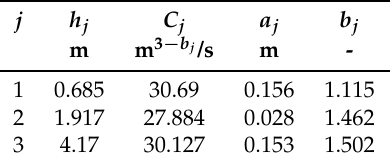
Table 1. The latest [14] coefficients C j , a j , b j and limb thresholds h 0 = 0.2 and h j for j = 1,2,3 for the rating curve at the river-level gauge station at Armley in